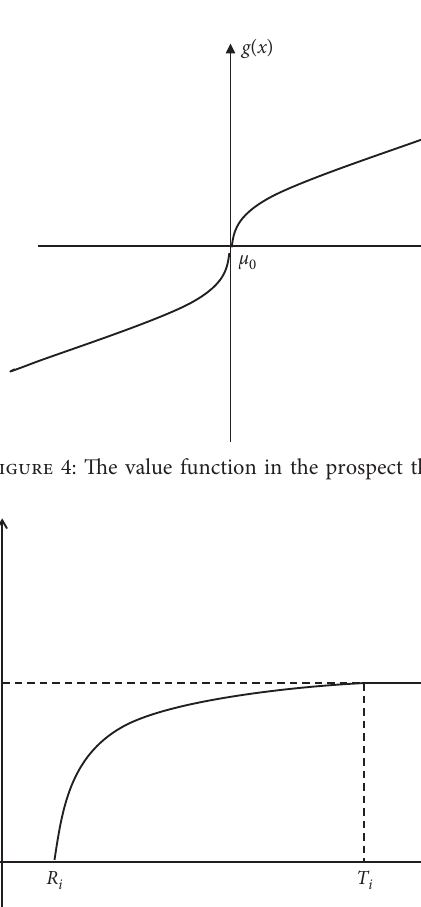
Figure 5: Dissatisfaction function for customer i